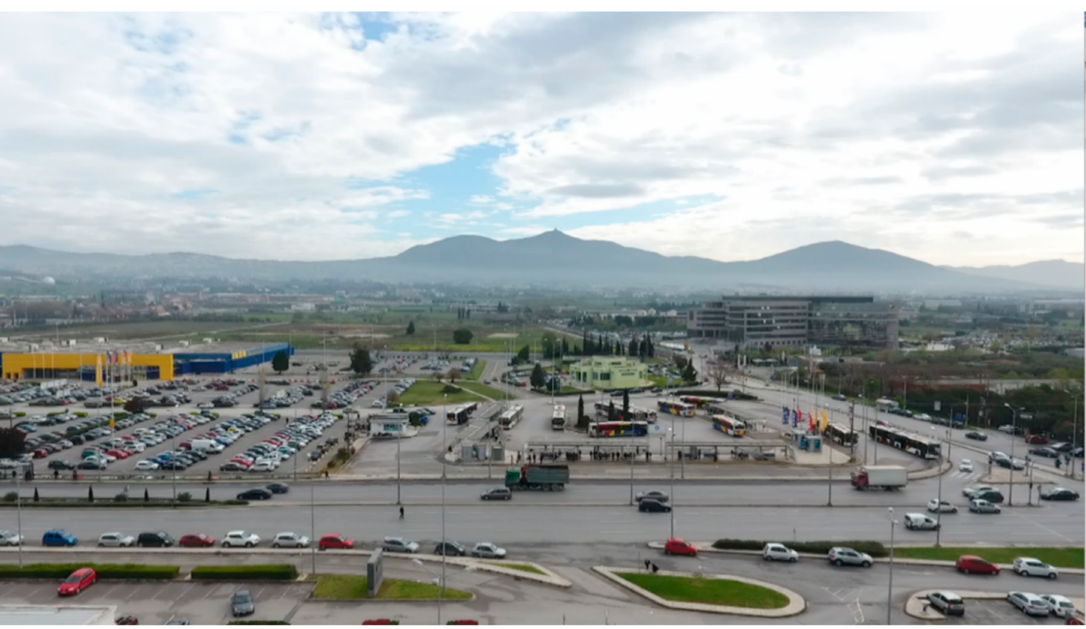
Figure 3. Photographic capture of the study area with the use of unmanned aerial vehicle